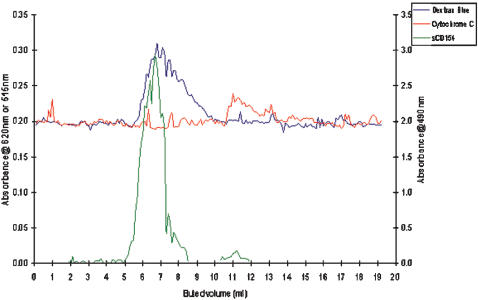
Fractionation of C4BP/sCD154 complex by gel filtration. C4BP and sCD154 were incubated together at 37°C for 1 hour. After this time the solution was eluted on a Sepacryl-300 with 100 ul fractions collected up to a final eluted volume of 20 ml, which encompassed void volume through to the lower limit of the fractionation range ( Dextran blue to cytochrome C). Fractions were assayed for the presence of sCD154 using a commercially available ELISA kit.